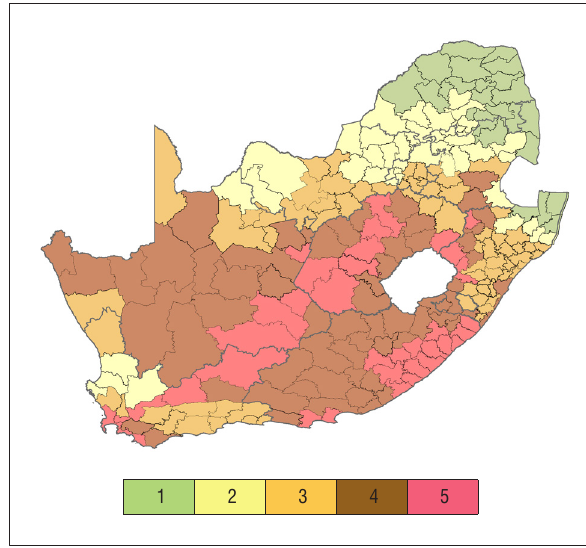
Figure 8: Relative wind hazard for all seasons combined on a scale of 1 (low wind hazard risk) to 5 (highest risk).